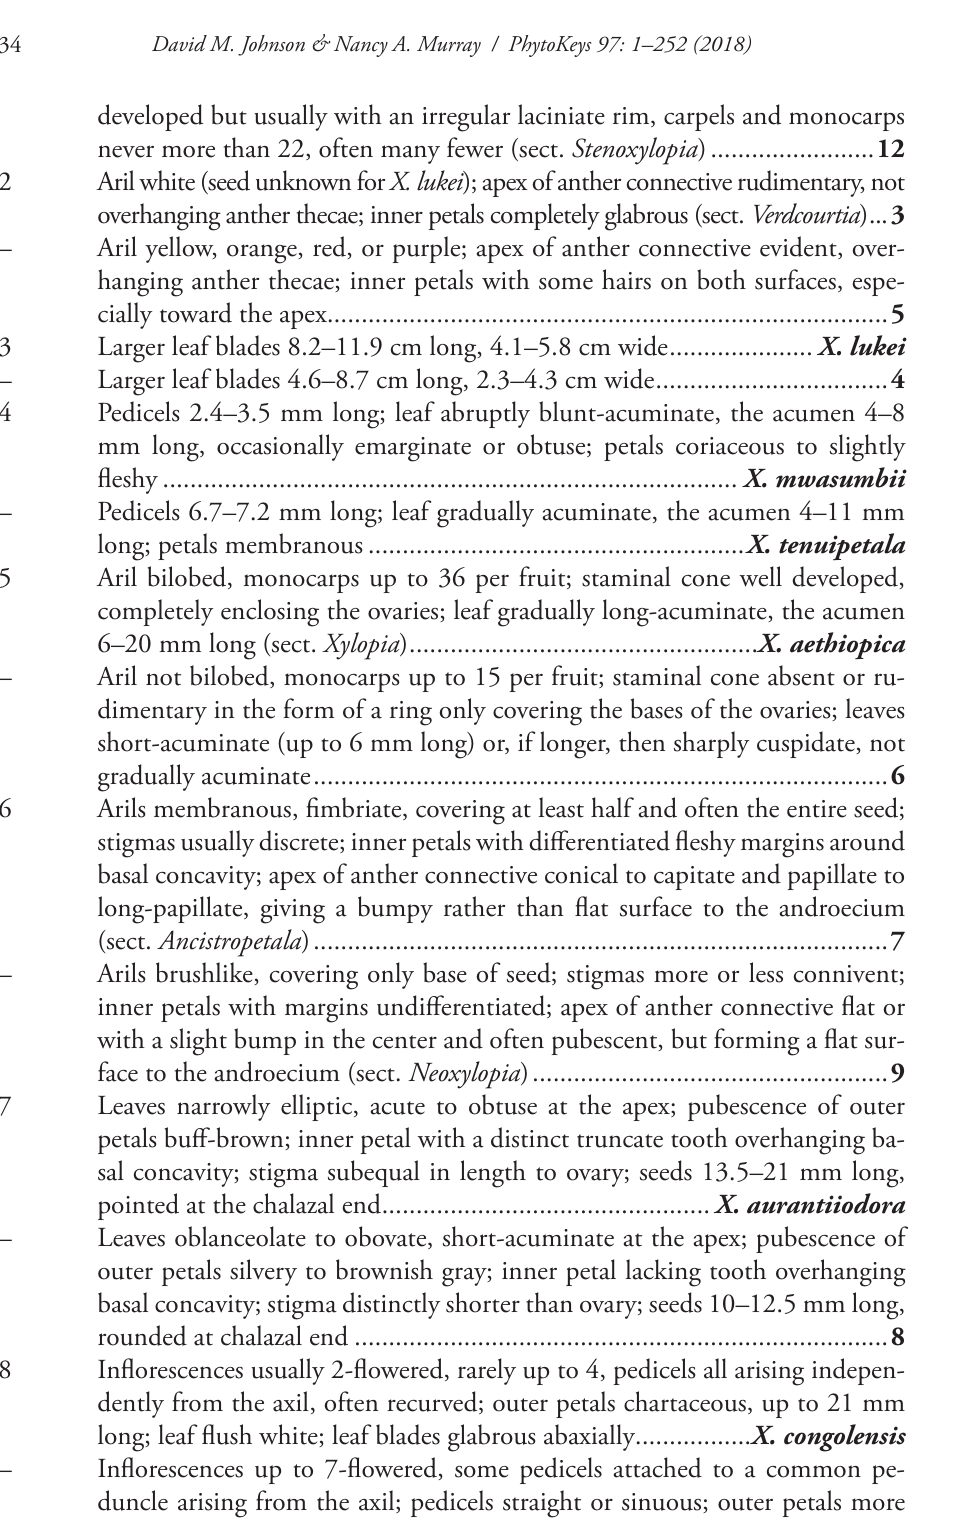
completely enclosing the ovaries; leaf gradually long-acuminate, the acumen 6–20 mm long (sect. Xylopia ) ................................................... X. aethiopica Aril not bilobed, monocarps up to 15 per fruit; staminal cone absent or ru- dimentary in the form of a ring only covering the bases of the ovaries; leaves short-acuminate (up to 6 mm long) or, if longer, then sharply cuspidate, not gradually acuminate .................................................................................... 6 Arils membranous, fimbriate, covering at least half and often the entire seed; stigmas usually discrete; inner petals with differentiated fleshy margins around basal concavity; apex of anther connective conical to capitate and papillate to long-papillate, giving a bumpy rather than flat surface to the androecium (sect. Ancistropetala ) .................................................................................... 7 Arils brushlike, covering only base of seed; stigmas more or less connivent; inner petals with margins undifferentiated; apex of anther connective flat or with a slight bump in the center and often pubescent, but forming a flat sur- face to the androecium (sect. Neoxylopia ) .................................................... 9 Leaves narrowly elliptic, acute to obtuse at the apex; pubescence of outer petals buff-brown; inner petal with a distinct truncate tooth overhanging ba- sal concavity; stigma subequal in length to ovary; seeds 13.5–21 mm long, pointed at the chalazal end ................................................ X. aurantiiodora Leaves oblanceolate to obovate, short-acuminate at the apex; pubescence of outer petals silvery to brownish gray; inner petal lacking tooth overhanging basal concavity; stigma distinctly shorter than ovary; seeds 10–12.5 mm long, Inflorescences usually 2-flowered, rarely up to 4, pedicels all arising indepen- dently from the axil, often recurved; outer petals chartaceous, up to 21 mm long; leaf flush white; leaf blades glabrous abaxially ................. X. congolensis Inflorescences up to 7-flowered, some pedicels attached to a common pe- duncle arising from the axil; pedicels straight or sinuous; outer petals